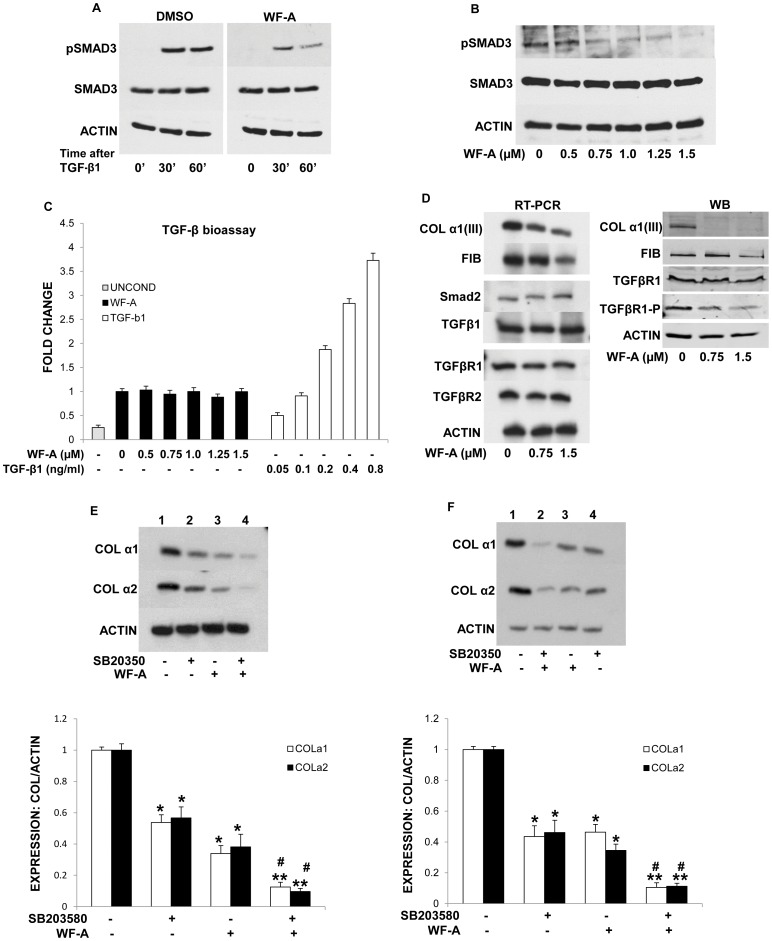
WF-A inhibits TGF-β1 signaling.A. WF-A inhibits TGF-β1 induced Smad3 phosphorylation. HLF were treated with DMSO (left panel) or WF-A (1.5 µM) (right panel) and stimulated by TGF-β1. Phospho-Smad3 and total Smad3 were measured by Western blot after indicated times. Loading control: actin. B. WF-A inhibits constitutive Smad3 phosphorylation in a dose dependent manner. Similar experiment as in A, HLF were treated with WF-A (0–1.5 µM). Loading control: actin. C. WF-A does not affect the amount of active TGF-β1 produced by HLF. HLF were treated with WF-A (0–1.5 µM) for 24 h. Conditioned medium from HLF was added to Ming lung epithelial cells (MLEC) stably transfected with TGF-β1 luciferase responsive promoter (PIA-Luc). Luciferase activity was measured in MLEC lysates. Gray bar: unconditioned medium, black bars: HLF conditioned medium, white bars: MLEC treated with recombinant TGF-β1 (0.05–0.8 ng/ml). Each bar represents three independent experiments analyzed in duplicate. Error bars: ±1SEM. D. Effect WF-A on expression of TGF-β1 relevant genes. mRNA of collagen III (COL α1(III)), fibronectin (FIB), Smad2, TGF-β1, TGF-β receptor 1 (TGFβR1) and TGF-β receptor 2 (TGFβR2) from control cells and HLF treated with WF-A (0.75–1.5 µM) were analyzed by RT-PCR (left panel). Protein COLα1(III), FIB, TGFβR1 and phospho-TGFβR1 were analyzed by Western blot (right panel). Loading control: actin. E. Synergistic effect of p38 MAPK inhibitor (SB203580) and WF-A. HLF were treated with SB203580 (10 µM, lane 2), WF-A (1.5 µM, lane 3) or both (lane 4), DMSO (lane 1). COLα1 and COLα2 mRNAs were analyzed after 24 h by RT-PCR. Loading control: actin mRNA. Bottom panel: expression of collagen α1(I) mRNA (open bars) and α2(I) mRNA (black bars) were normalized to actin mRNA and plotted from three independent experiments. The error bars: ±1SEM. F. Effect of SB203580 and WF-A in SCL. Similar experiment as in E. * represents p<0.05 and # represents p<0.01.